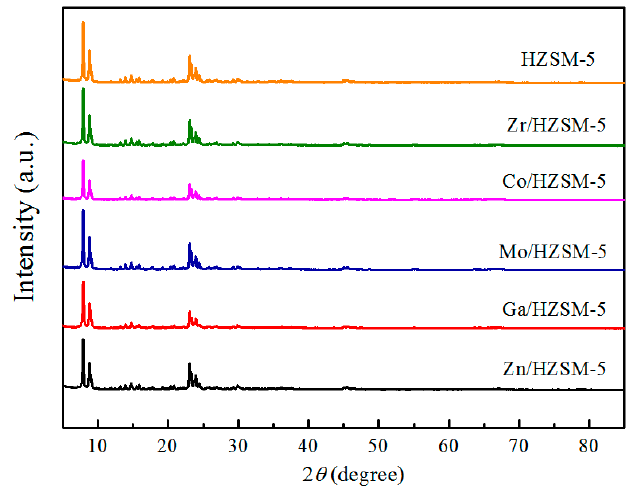
Figure 1. X-ray diffraction patterns of the catalysts with hydrogen pre-treatment at 873 K for 2 h. Table 1. Texture properties of the catalysts a .